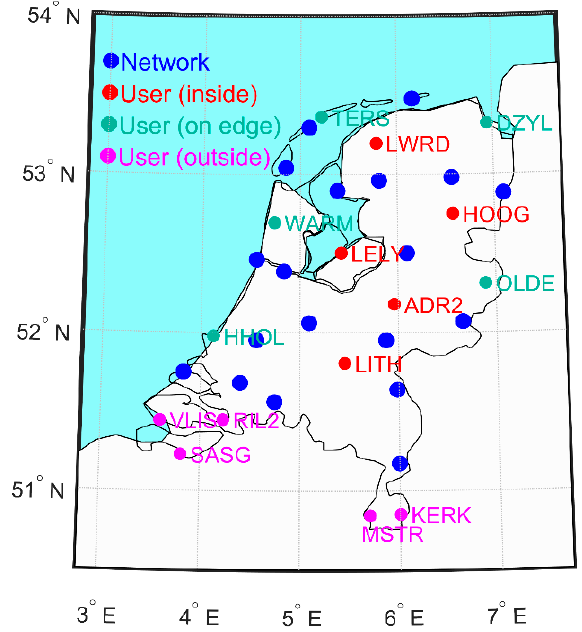
Figure 2. Dense GNSS network with 19 reference stations and 15 user stations.